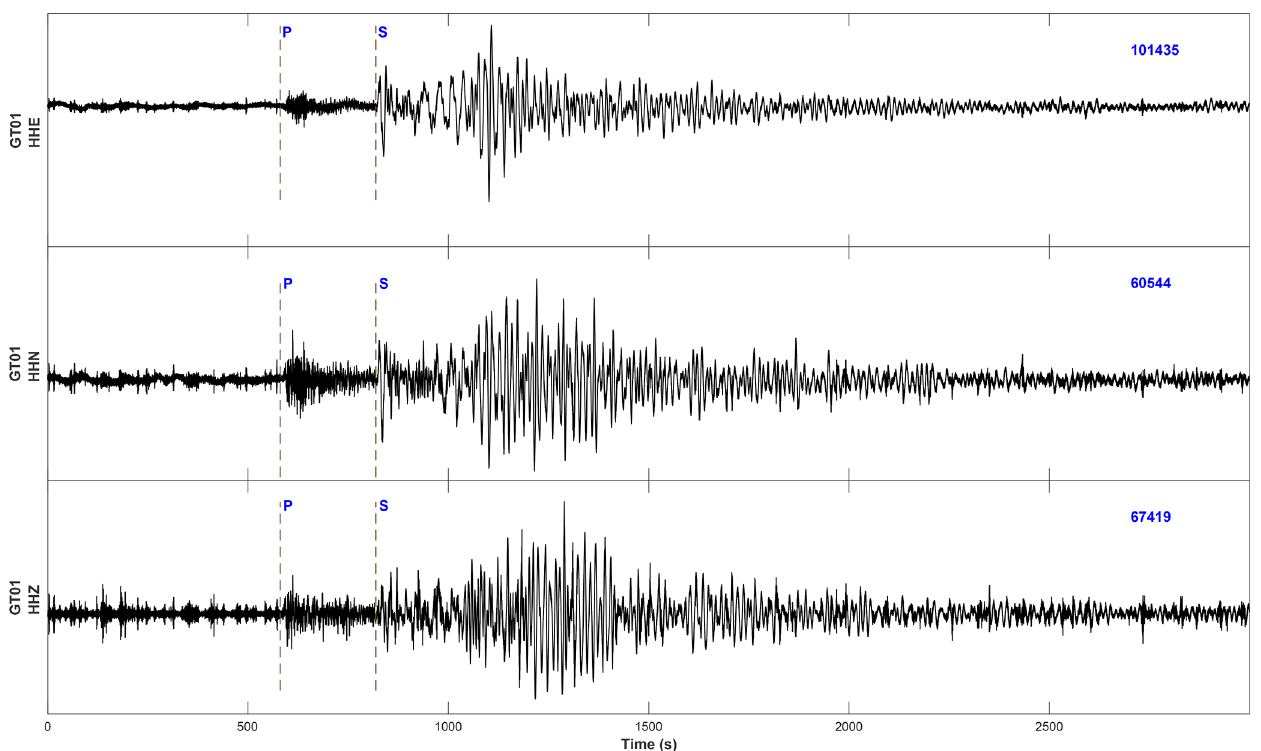
Figure 10. Seismic recording of the magnitude-6.8 earthquake that occurred 44km SW of Mouzaki, Greece, on 25 October 2018. The earthquake occurred at a depth of 14km and was ∼ 2400km from the recording station (GT01) in the Wills Memorial Building. The HHZ trace shows the vertical component of ground motion, and the HHE and HHN traces show the two horizontal components, which are oriented E–W and N–S, respectively. P-wave and S-wave arrivals are indicated; the stronger lower-frequency energy that arrives after 1000s shows the arrival of the surface